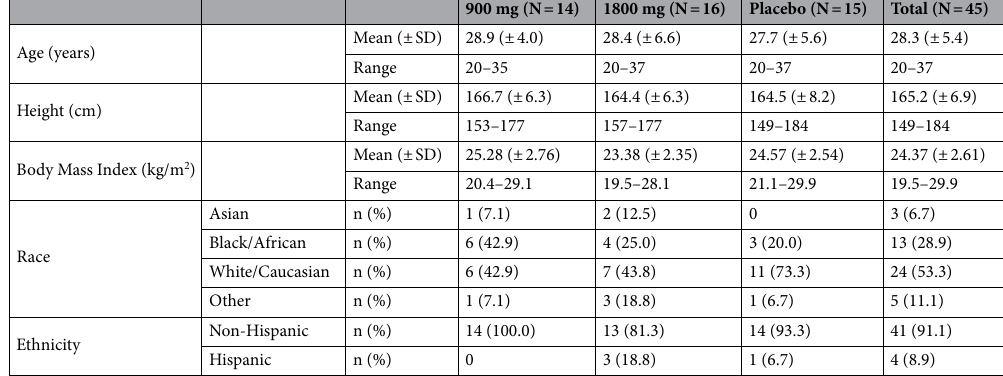
Table 1. Volunteer demographics. SD standard deviation.